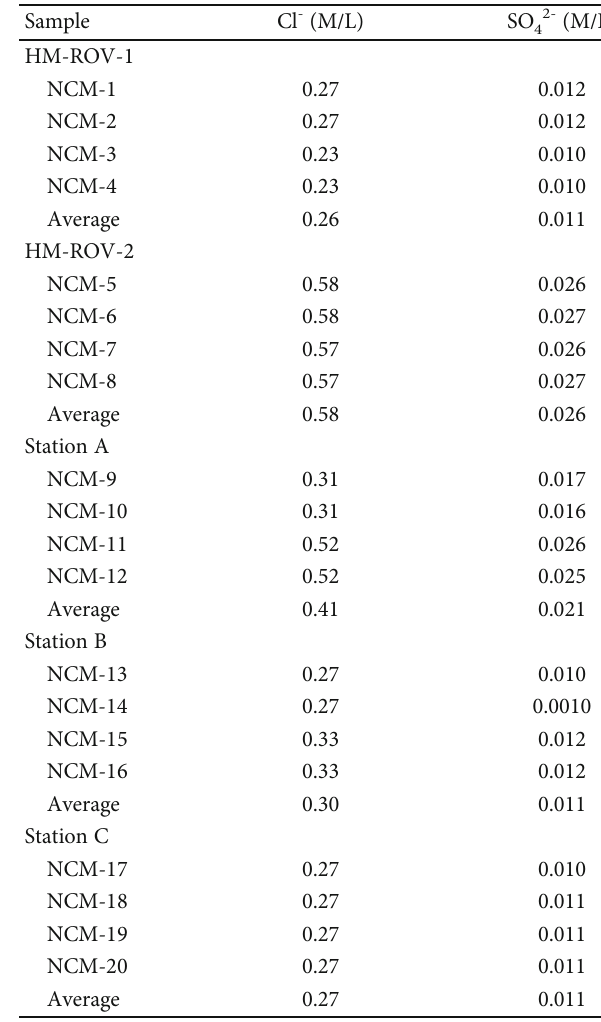
Table 4: Main anion concentrations of samples recovered from di ff erent cold